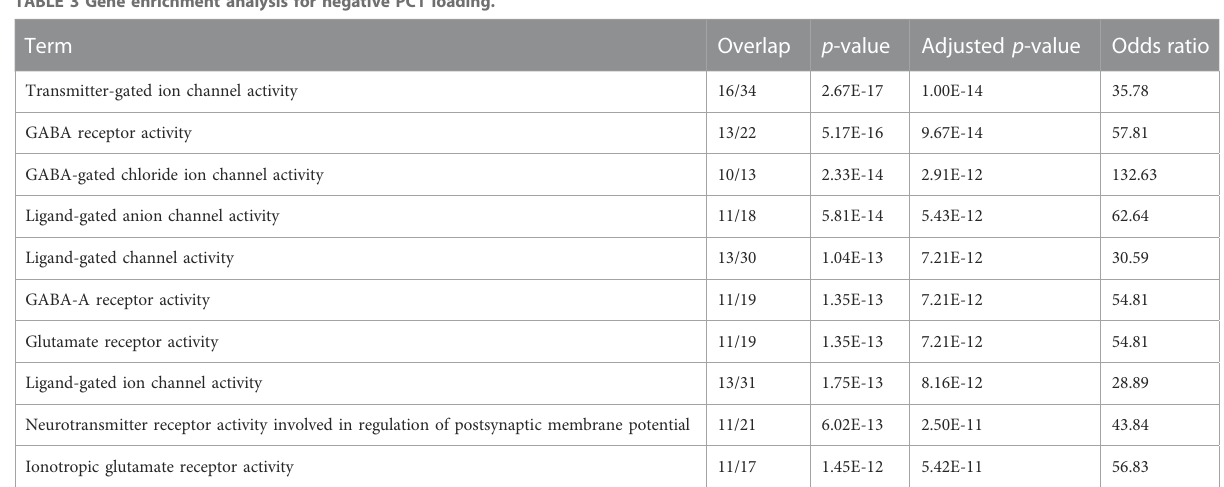
TABLE 3 Gene enrichment analysis for negative PC1 loading. Term